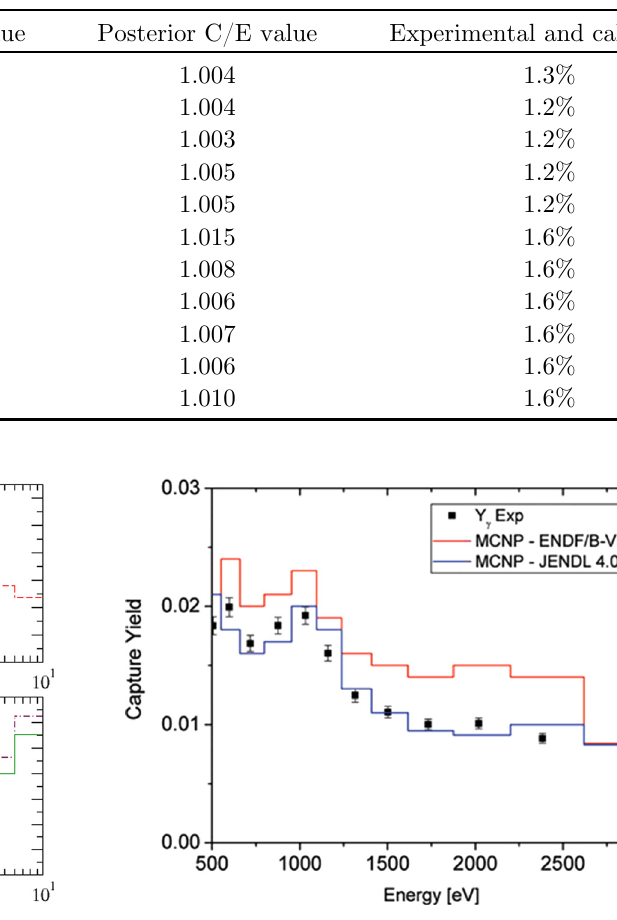
Fig. 6. Results of differential measurements from Danon et al. [14] for 235 U capture from 0.5 to 3 keV, compared with ENDF/B- VII.1 and JENDL-4.0